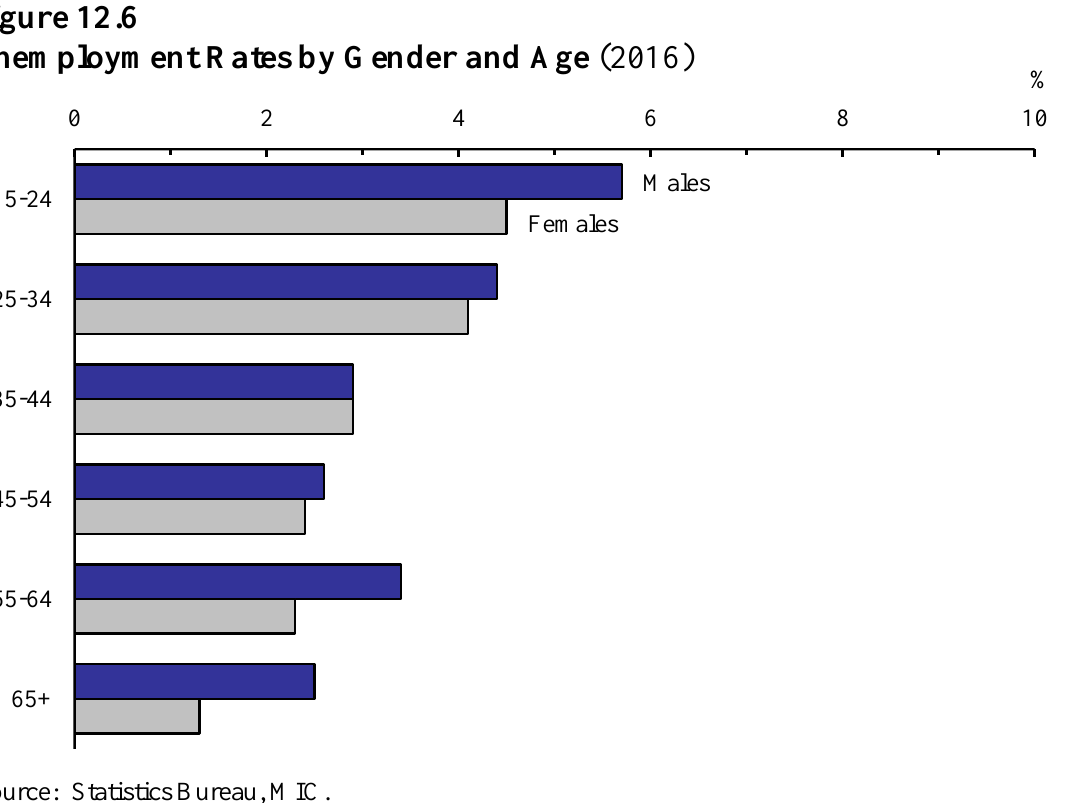
Source: Statistics Bureau,